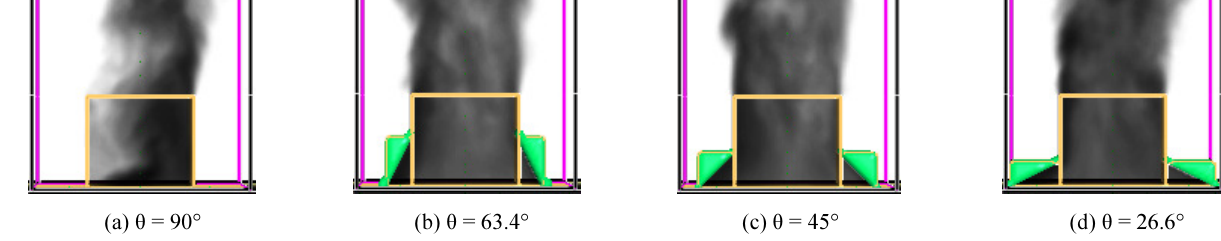
Fig. 9. Smoke soot field and flow pattern (the shaft height is 2.6 m)